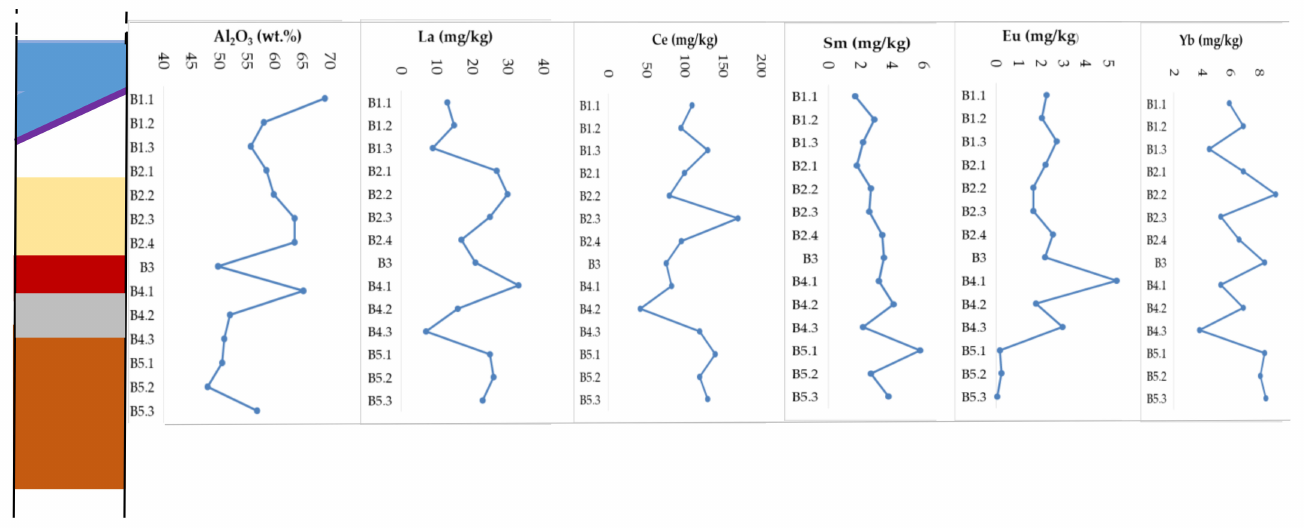
Figure 4. Schematic compositional variations for Al 2 O 3 , La, Ce, Sm, Eu, and Yb (similar to the variation for Lu), through a vertical bauxite profile (Figure 1). Data are from Table